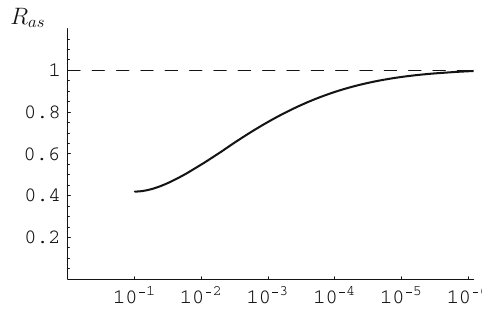
Fig. 2 Approach of A q to its asymptotics A as q at fixed Q 2 = μ 2